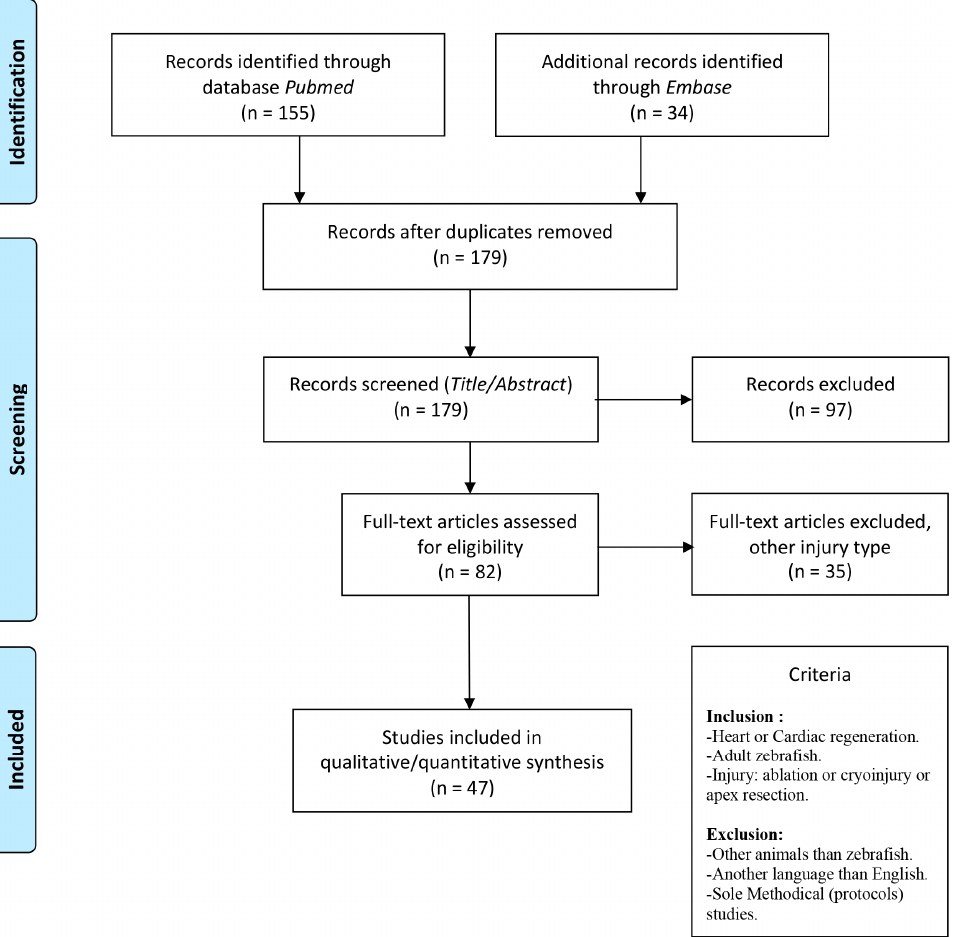
Figure 2. Flowchart of the literature search including inclusion and exclusion criteria. See methods and materials for details. As modified from PRISMA guidelines.